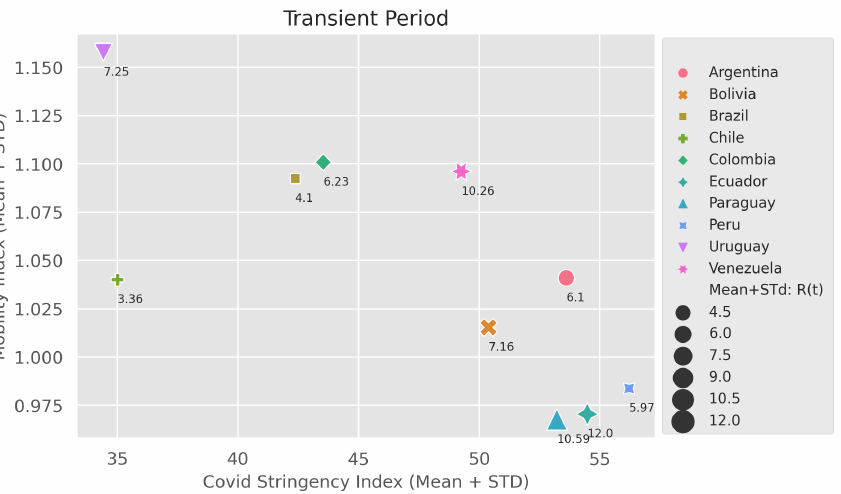
Figure 8. Community mobility index, Covid stringency index, and R ( t ) : Transient period. Source of basic data: Covid-19 Community Mobility Reports, Oxford Covid-19 Government Response Tracker (OxCGRT), and Covid-19 Community Centre for Systems Science and Engineering (CSSE) at Johns Hopkins University